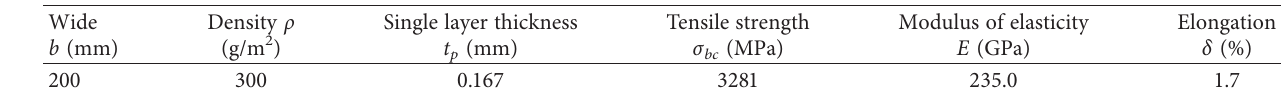
Table 5: Mechanical properties of CFRP.